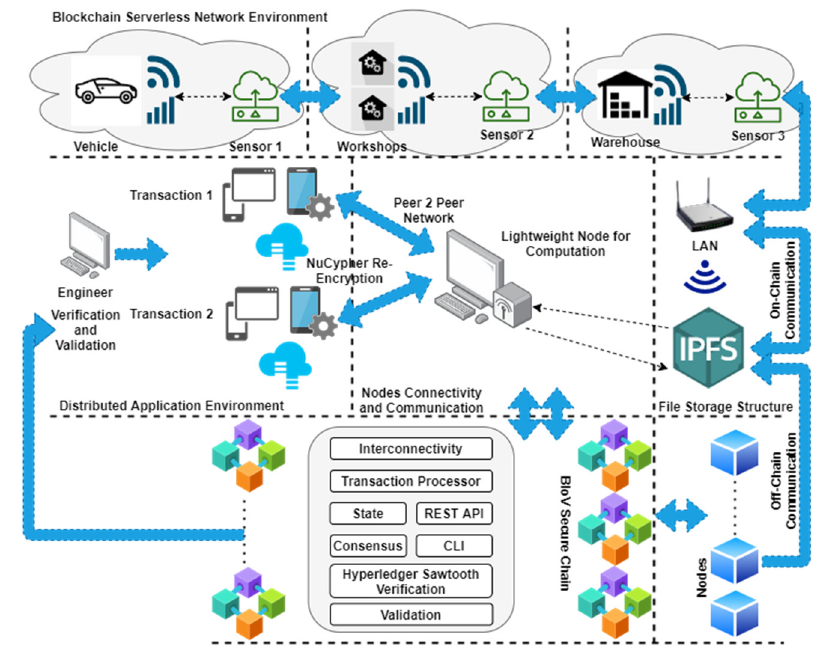
Figure 2. The Proposed Lightweight-BIoV Architecture.